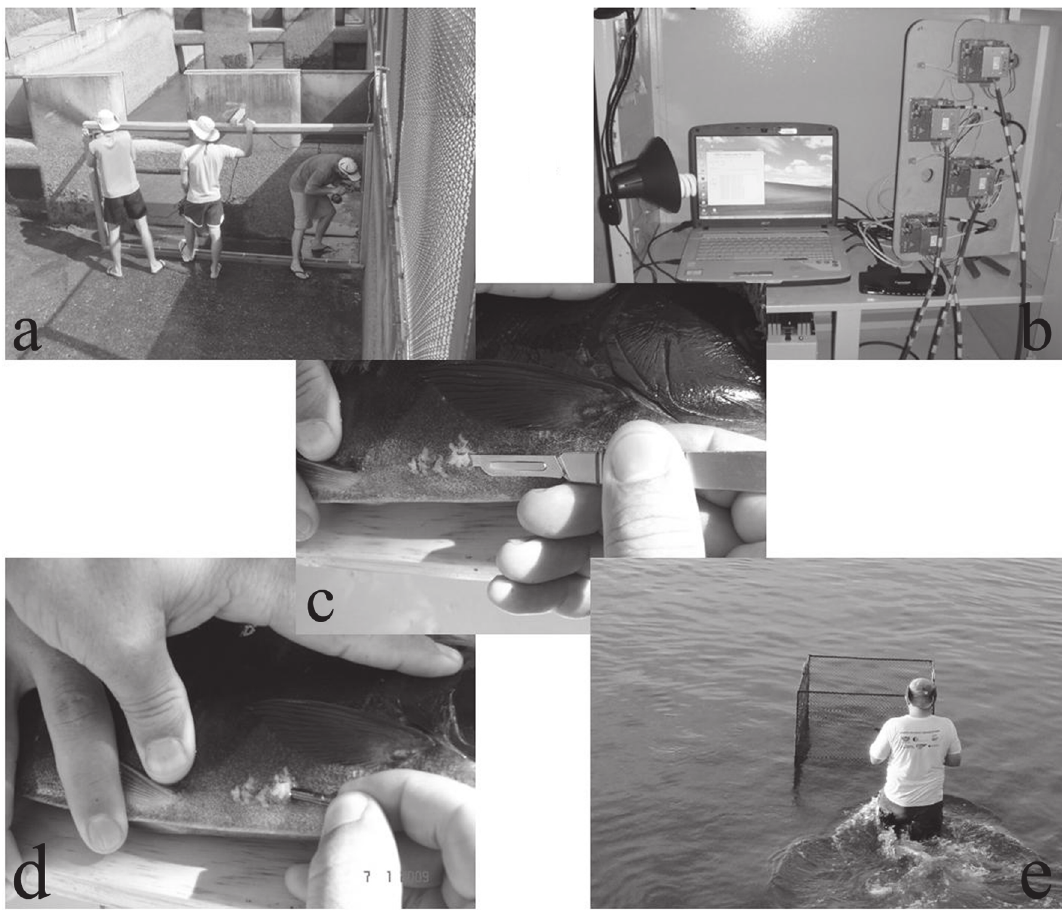
Fig. 3. Details of methodology: a ) installation of antenna, b ) RFID system, c and d ) marking of fish, e ) cages for fish.